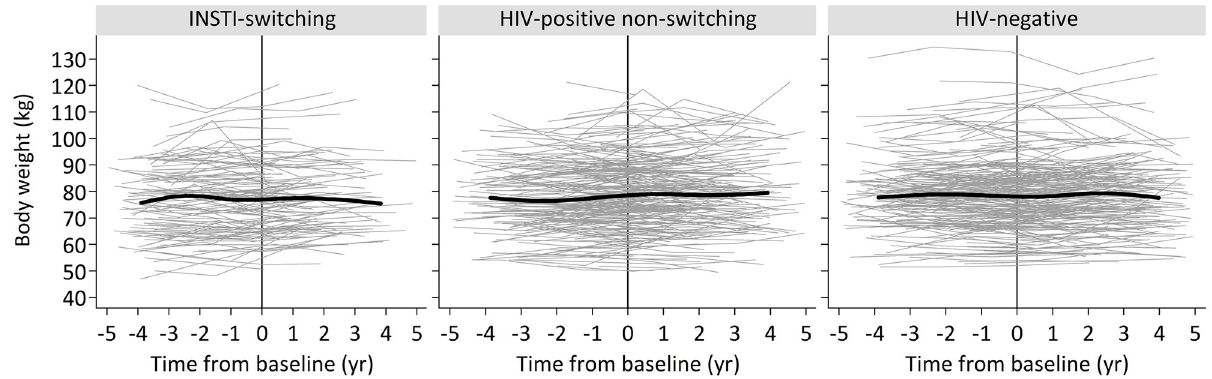
Fig 1. Median and per participant body weight trajectories of INSTI-switching, HIV-positive non-switching and HIV-negative selected participants. Grey lines demonstrate individual body mass index trajectories before and after baseline (i.e. moment of switch in INSTI-switching participants or at assigned hypothetical moment of switch in controls). Black lines are median splines (6 knots each) within each study group.